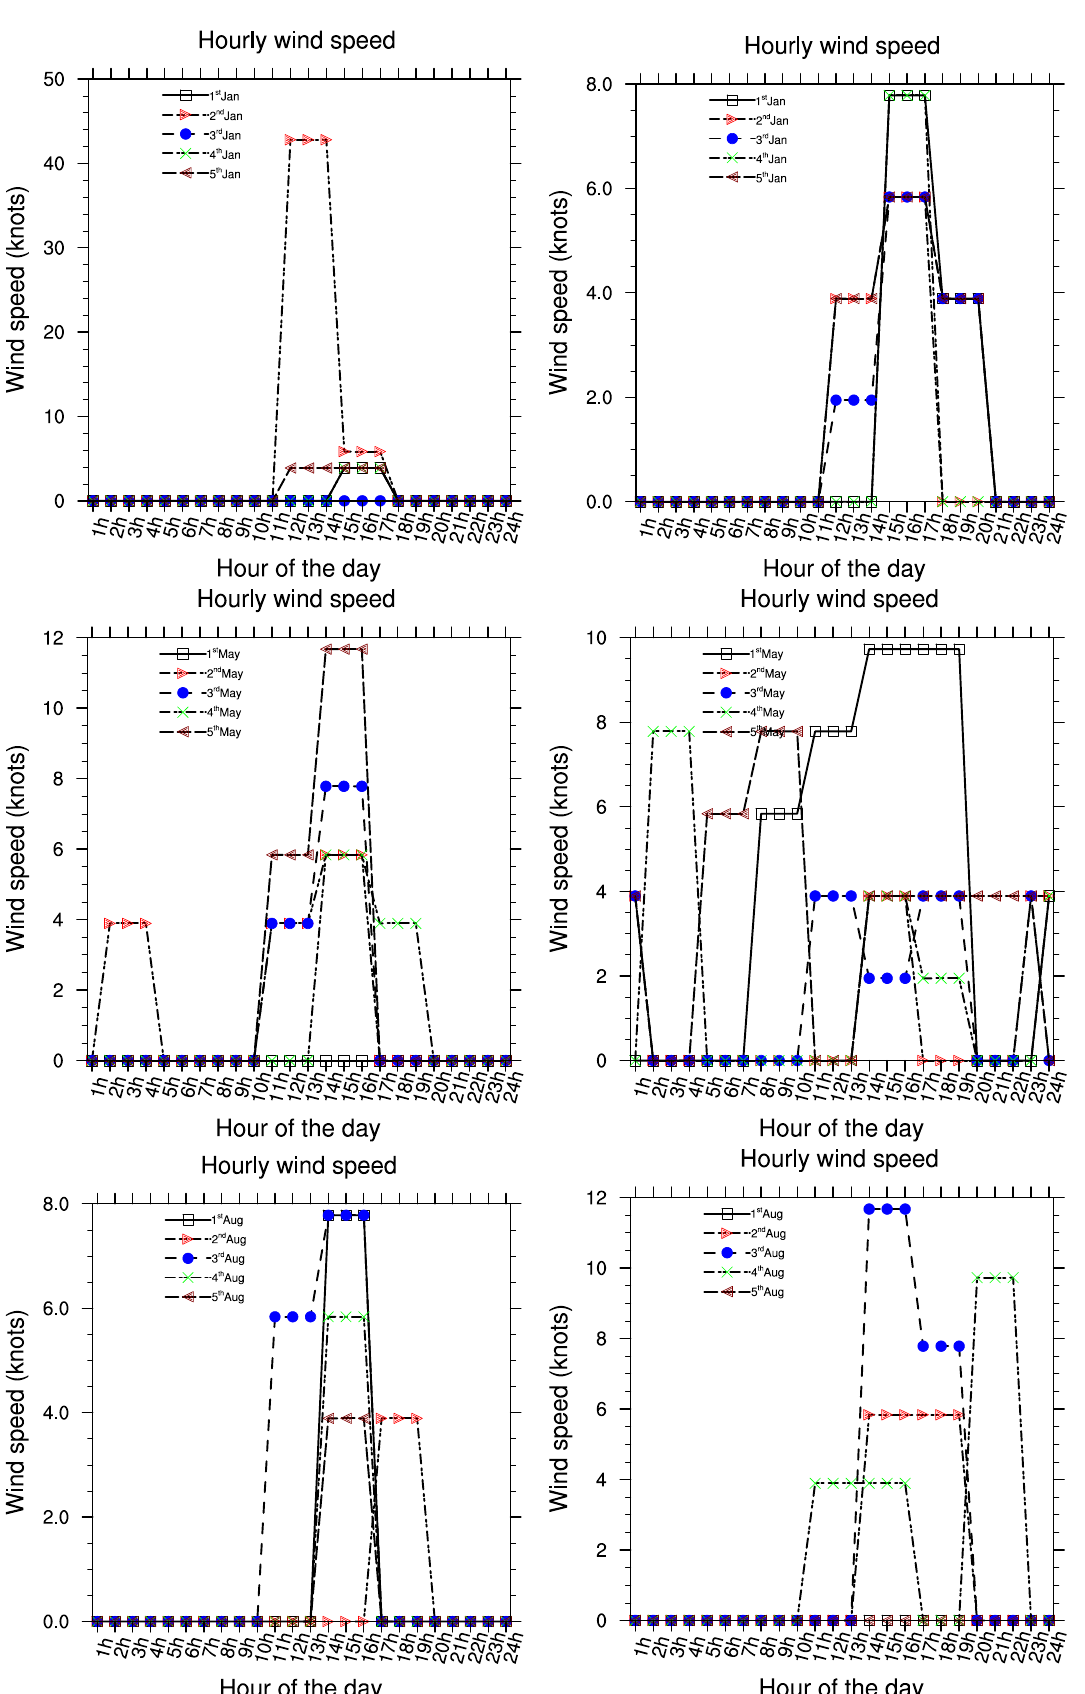
Figure 5. Daily wind speed for the first five days of the months of January, May and August from 2002 to 2003. The first label is for the year 2002 and the second label (column) is for the year